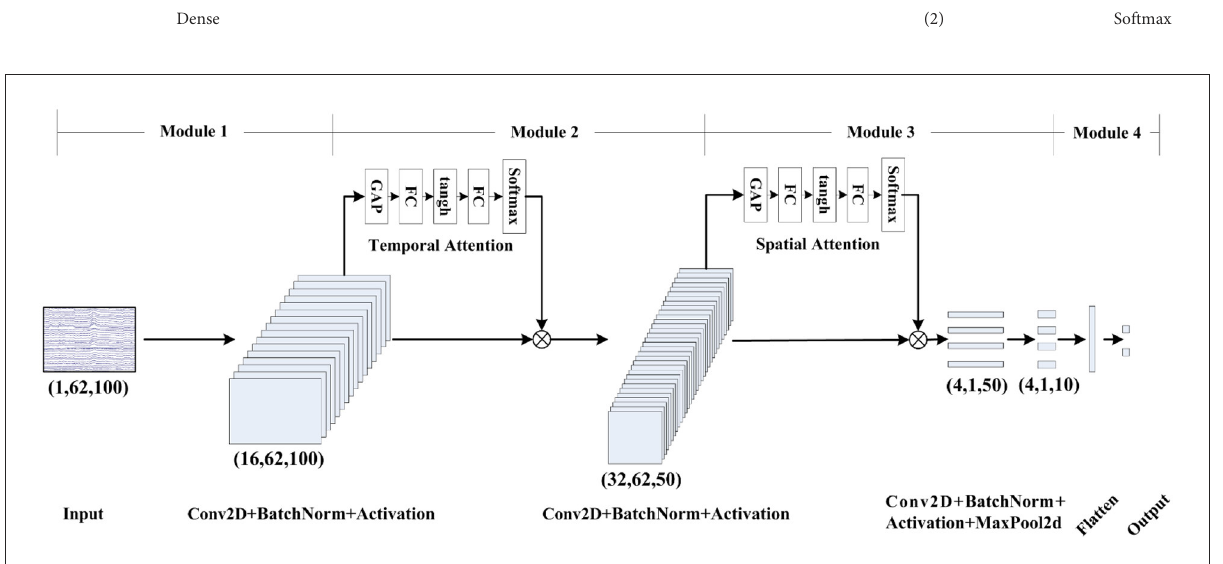
FIGURE2 Schematic diagram of STA-CNN